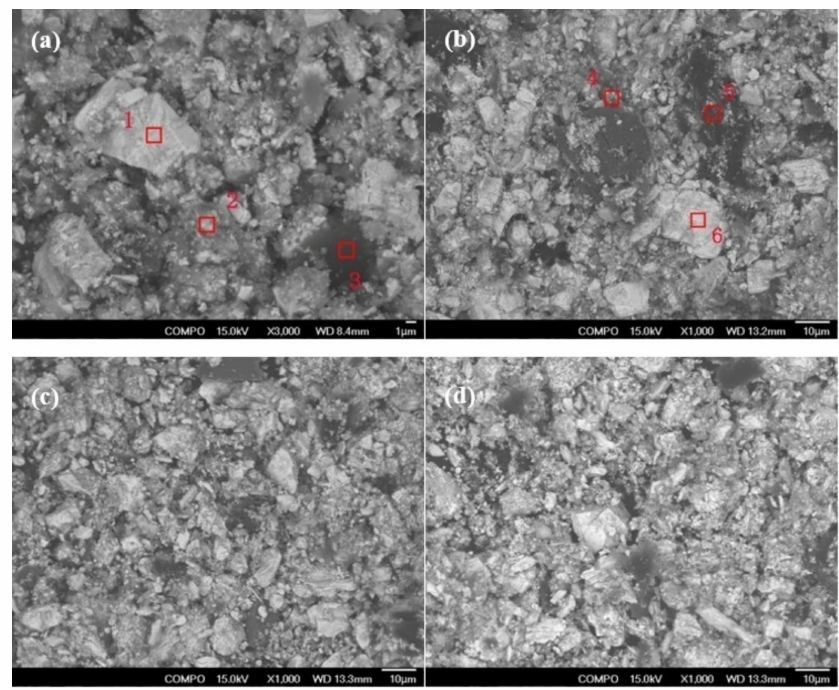
Figure 6. SEM diagram of decomposed slag under different oxygen partial pressures. ( a ) 1.5 MPa,